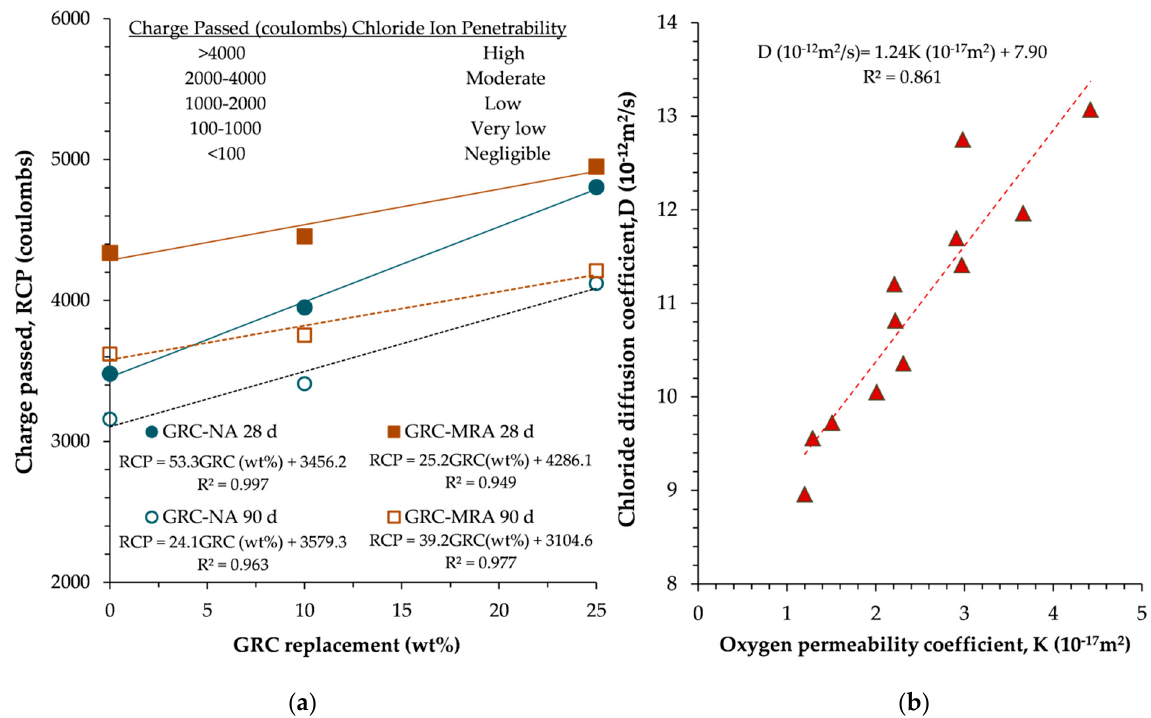
Figure 4. ( a ) Variation in RCP with the inclusion of GRC in 28 d and 90 d mixes; and ( b ) relationship between the chloride diffusion and oxygen permeability coefficients.